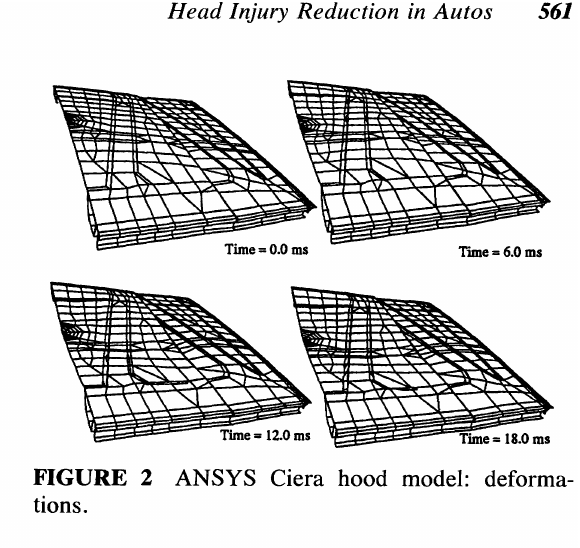
FIGURE 2 ANSYS Ciera hood model: deforma tions.